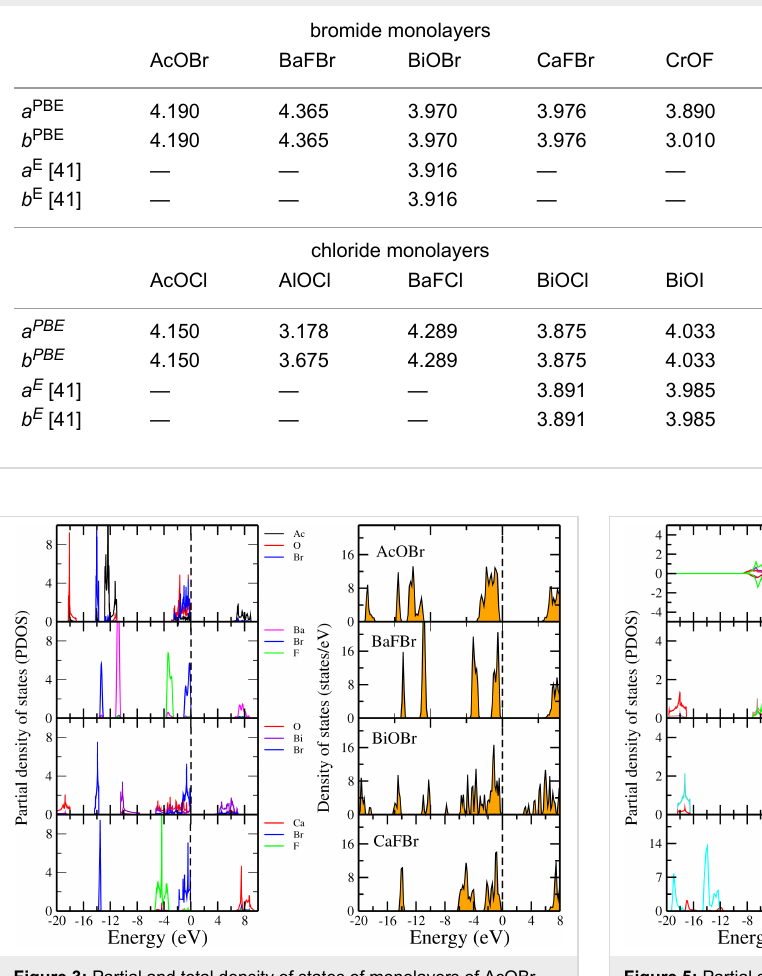
Figure 3: Partial and total density of states of monolayers of AcOBr, BaFBr, BiOBr, and CaFBr. The Fermi level is set to 0 eV.